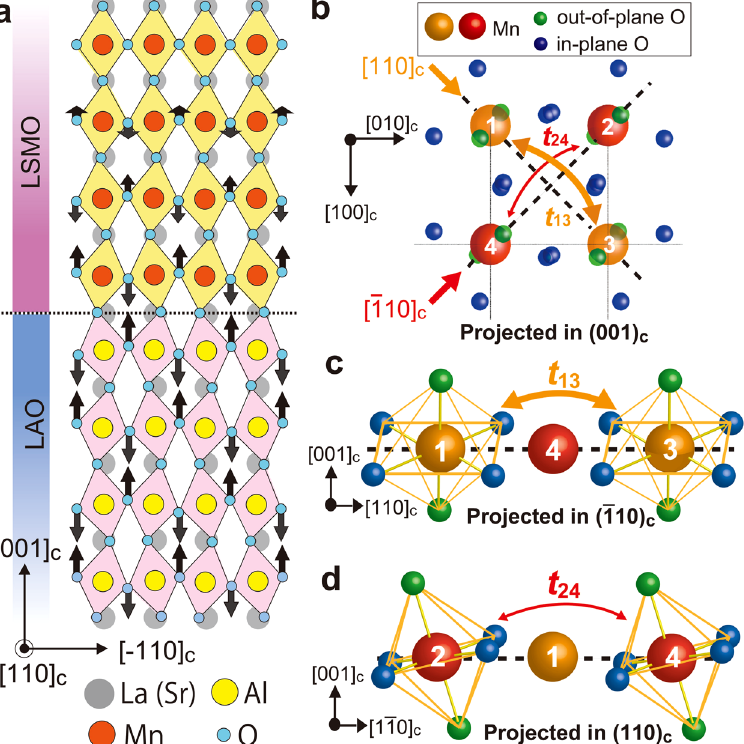
Figure 4. Origin of the two-fold symmetry magnetic anisotropy along the [110] c direction. ( a ) Illustration of the crystal structure at the LSMO/LAO interface when looked at from the [110] c direction. In LAO, adjacent corner-sharing oxygen octahedra rotate around the [111] axis in the opposite directions. This lattice distortion c is transferred to the first 3–4 u.c. layers of LSMO. ( b–d ) Illustration of four adjacent MnO 6 octahedra in a (001) c plane of LSMO near the LSMO/LAO interface, when projected in the (001) c ( b ), (110) ( c ), and (110) c ( d ) c planes. Due to the OOR around the [111] axis, the crystal symmetry between the [110] and [110] c directions is c c broken. Here, the in-plane and out-of-plane oxygen atoms are drawn in blue and green, respectively. The orange and red spheres represent Mn atoms located along the [110] c and [110] directions, respectively. The rotation c angle is largely